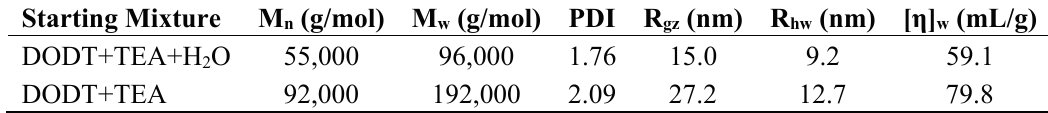
Table 4. Results from SEC analysis of poly(DODT)